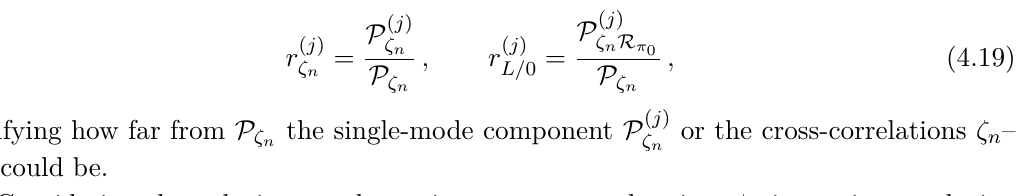
(cid:2) (cid:3) plot once ˆ P R / P ζ π 0 n 10 = − 1 b